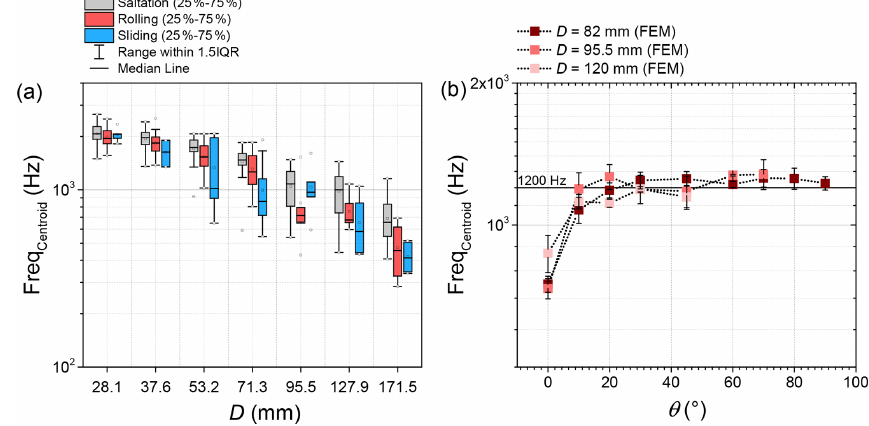
Figure 10. (a) Centroid frequency Freq Centroid versus bedload particle size D for different motion modes. (b) Centroid fre- quency Freq Centroid versus impact angle θ for different impacting particle sizes. FEM denotes simulations with the finite element